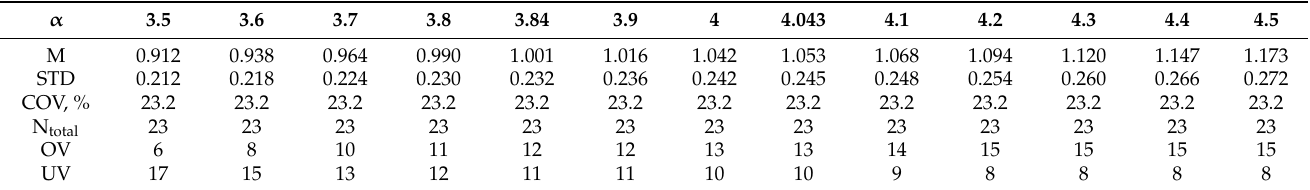
Table A7. The influence of α on the statistical results of L t.teor /L t.exp of AFRP Arapree bars.